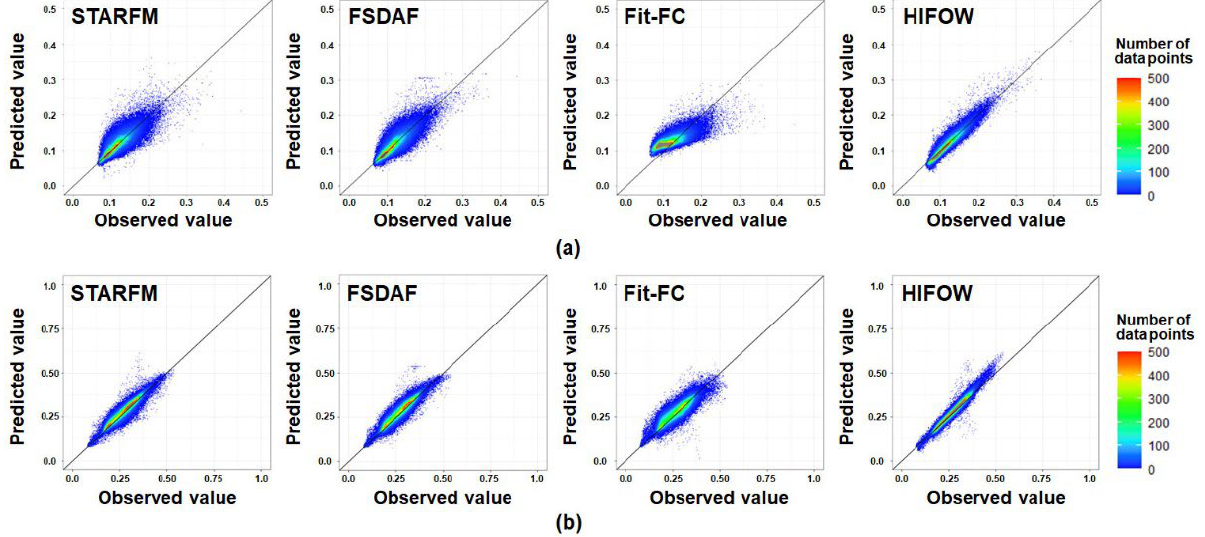
Figure 9. Scatter-density plots of predicted values versus actual values for different STIF models on Site 1: ( a ) red band; ( b ) NIR band.